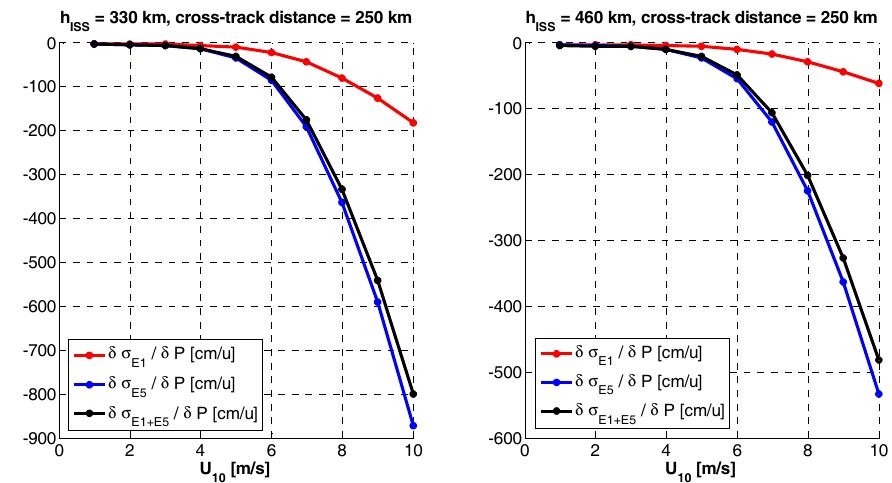
Figure 15. RMS height error sensitivity to antenna directivity (P) at nominal values as given by Table 3, u = [dB].